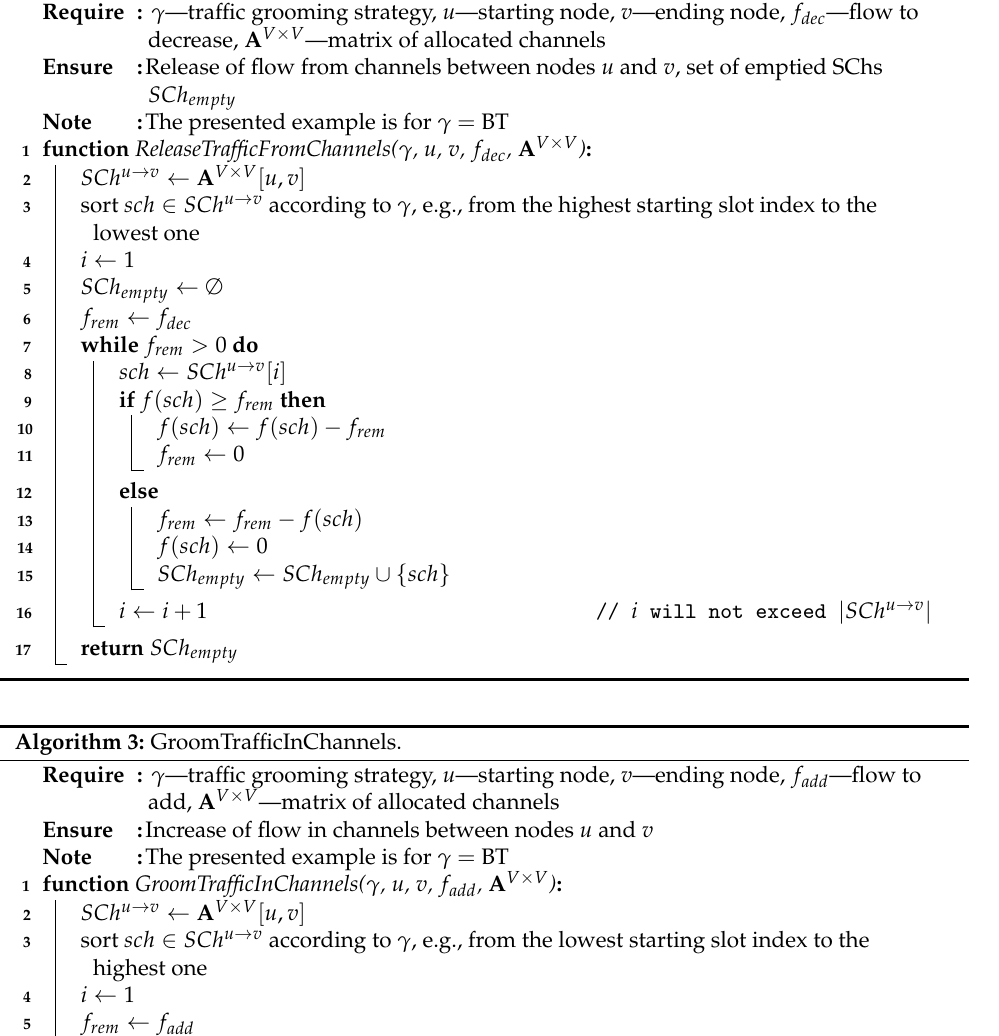
Algorithm 2: ReleaseTrafficFromChannels.